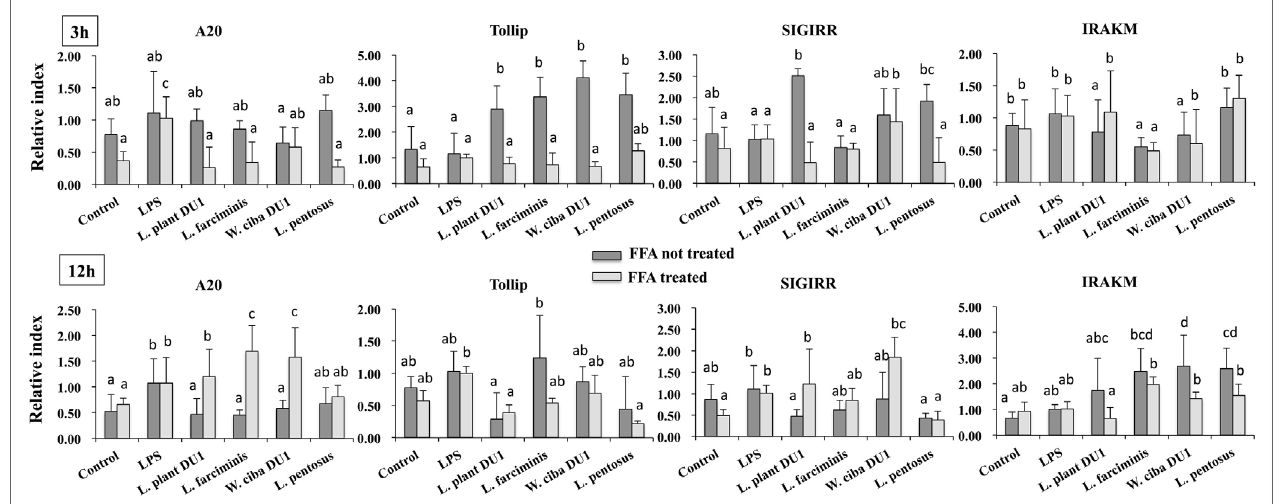
FigUre 7 | Total cellular fluid (TCF) of lactic acid bacteria (LABs) modulated LPS induced toll-like receptor negative regulators expressions in HepG2 cells. Confluence HepG2 cells were pre-stimulated with LABs TCF (50 µl/ml) for 48 h, then stimulated with LPS for 3 and 12 h. The mRNA levels of A20, SIGIRR, Tollip, and interleukin-1 receptor associated kinase-M1 were determined by RT-PCR. HepG2 cells either with medium or LPS was used as control. Three independent experiments were performed for each case and the mean value was presented as immunomodulatory activity of LABs. Different superscript letters indicate significant differences at the 0.05